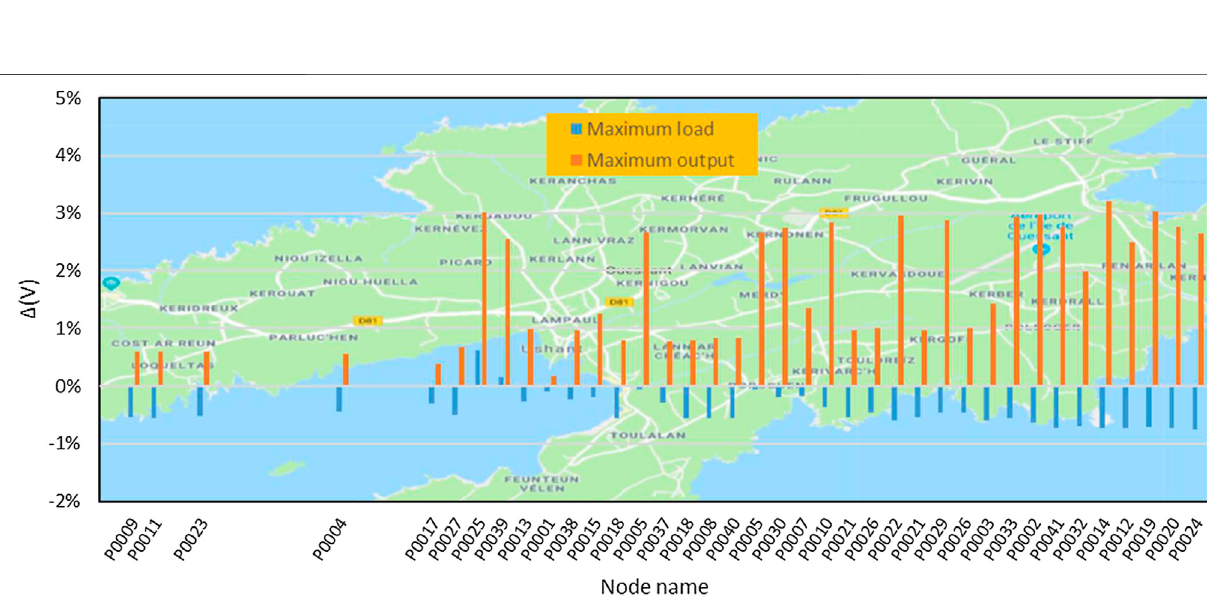
Frontiers in Energy Research |